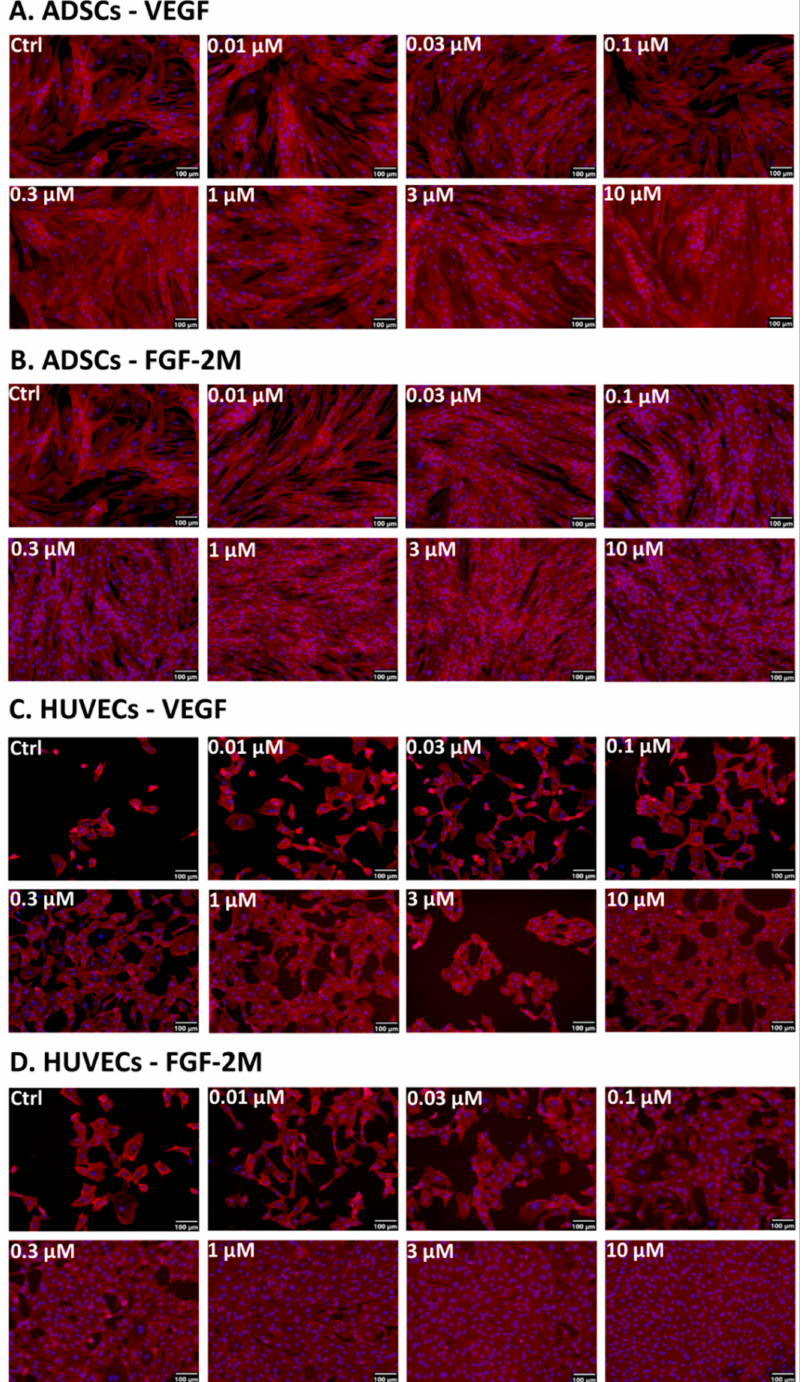
Figure 5. Microphotographs of ADSCs ( A , B ) and HUVECs ( C , D ) on day 7 after seeding into wells pre-adsorbed with VEGF-A 165 ( A , C ) or FGF-2M ( B , D ) in concentrations from 0.01 to 10 µ M. The filamentous actin in cells was stained with phalloidin-TRITC to visualize the cell morphology. The nuclei were counterstained with Hoechst 33258. Olympus IX 71 microscope, DP 70 digital camera, obj. 10 × , scale bar 100 µ